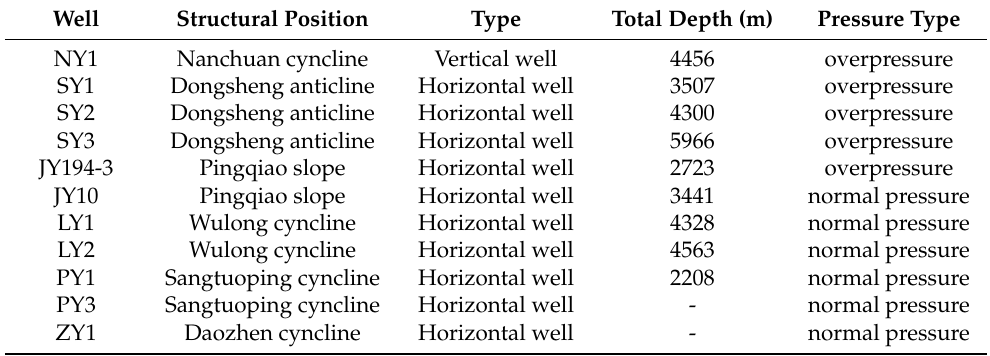
Table 3. Well data in the study